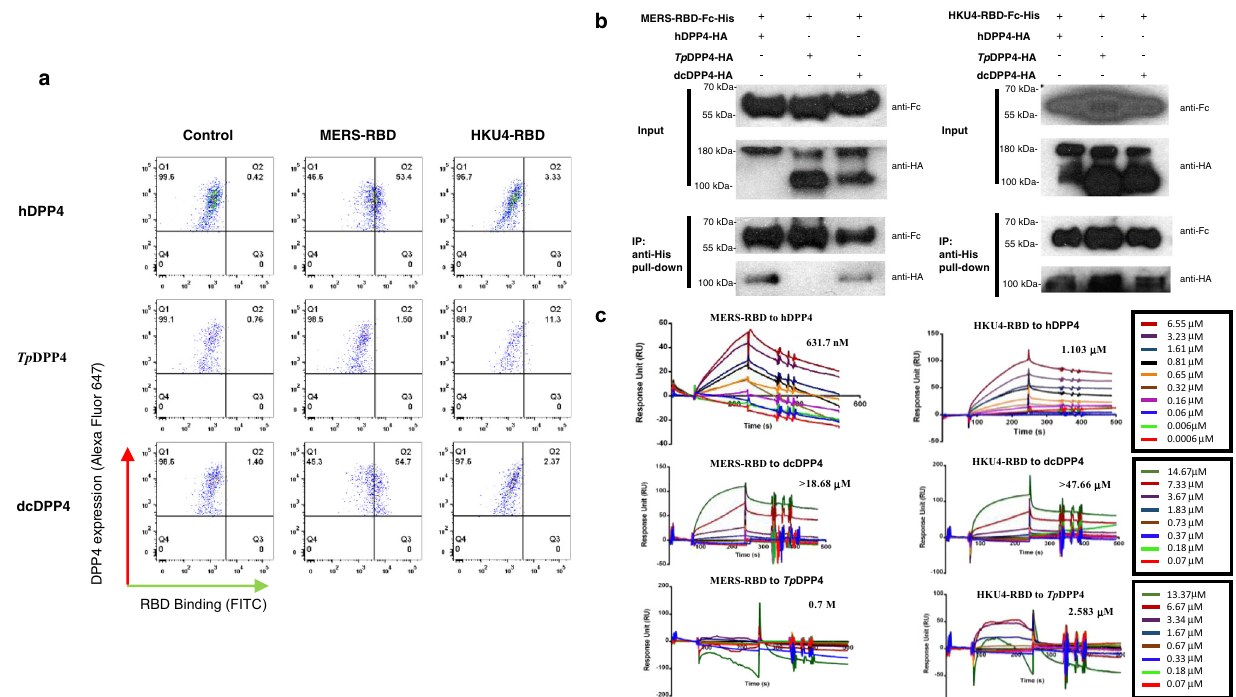
Fig. 3 Speci fi c interaction of MERS-RBD, HKU4-RBD with hDPP4, Tp DPP4, and dcDPP4. a Characterization of binding af fi nity of MERS-RBD, HKU4-RBD with hDPP4, Tp DPP4, and dcDPP4 by fl ow cytometry. HEK293T cells expressing various DPP4s were detected by the Alexa Fluor 647 channel. MERS-RBD, HKU4-RBD were detected by FITC channel. b Characterizing interaction of MERS-RBD-Fc-His, HKU4-RBD-Fc-His with hDPP4, Tp DPP4, dcDPP4 by co-IP assays. DPP4s were expressed as monomer or homodimer. Images are representative of three independent experiments. Uncropped blots in Source Data are provided as Source Data fi le. c Interaction between various combinations of RBD and DPP4 characterized by SPR assay with Biacore X100. The binding pro fi les were shown in the form of sensorgram with gradient concentrations of DPP4